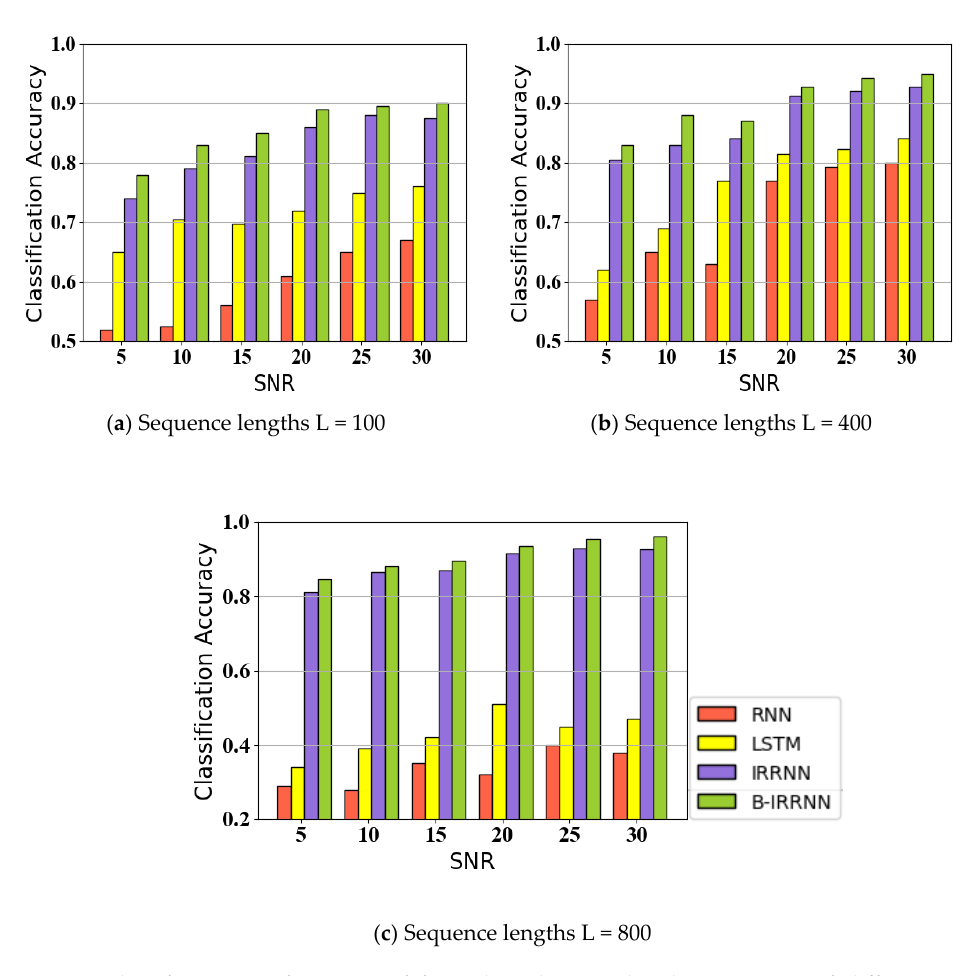
Figure 7. Classification performance of four algorithms under the situations of di ff erent SNR sequence lengths.